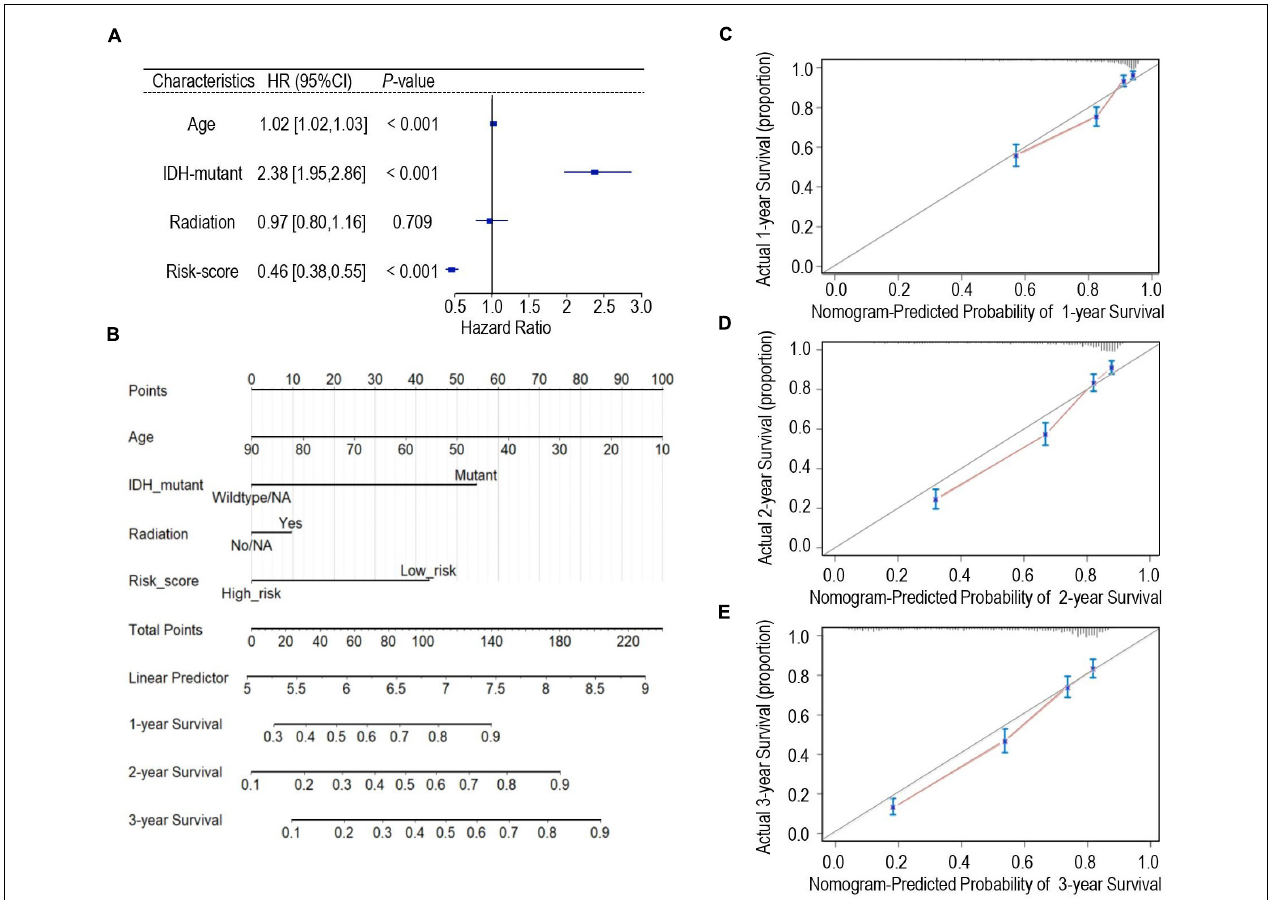
FIGURE 5 | Development of the nomogram predicting the overall survival for glioma patients. (A) Forest plot of the multivariate Cox regression analysis indicated that the risk-score was an independent predictor for OS. (B) Nomogram model for predicting the probability of 1-year, 2-year, and 3-years OS in gliomas. (C–E) Calibration curves of the nomogram model concerning consistency between predicted and actual 1-year (C) , 2-year (D) , and 3-year (E)